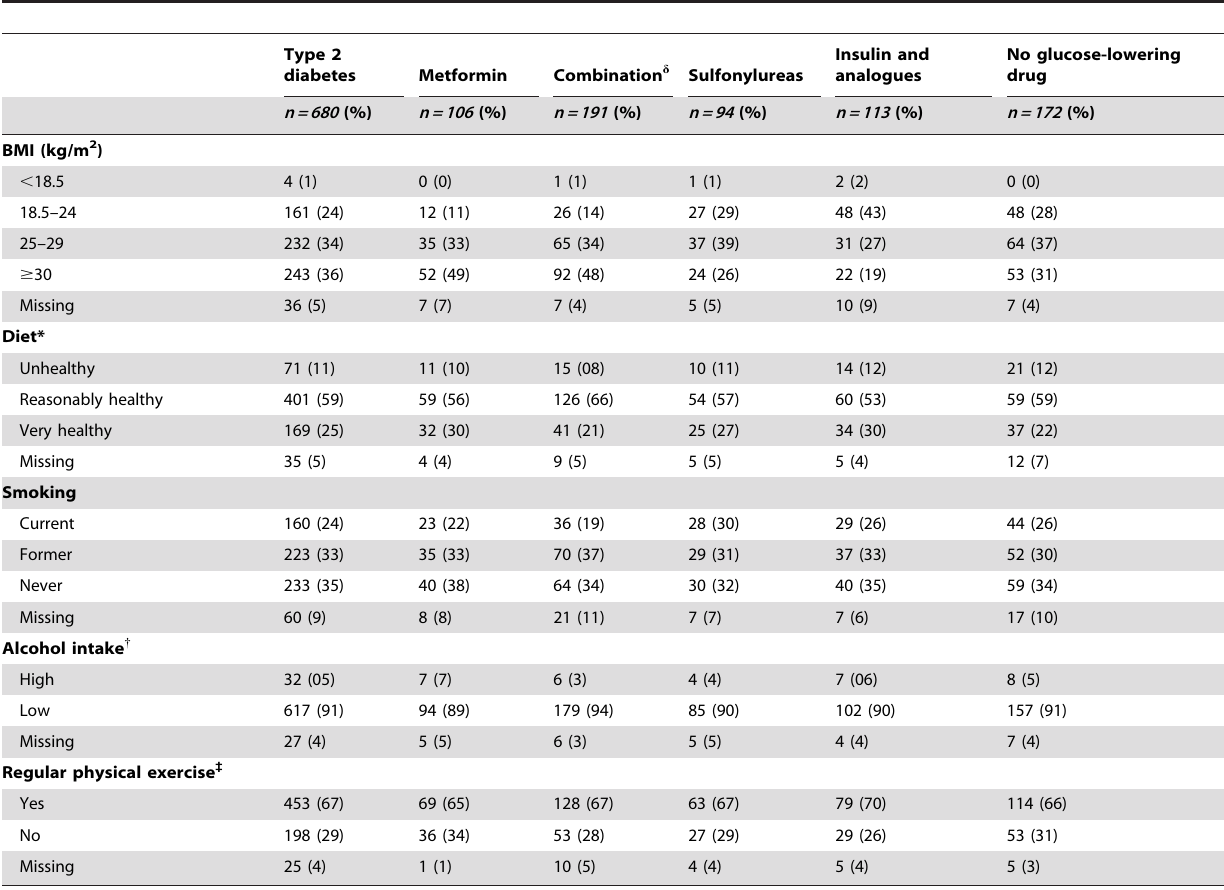
Table 4. Distribution of lifestyle factors according to glucose-lowering drug use among 680 individuals with type 2 diabetes participating in the Danish ‘‘How are you?’’ public health survey in